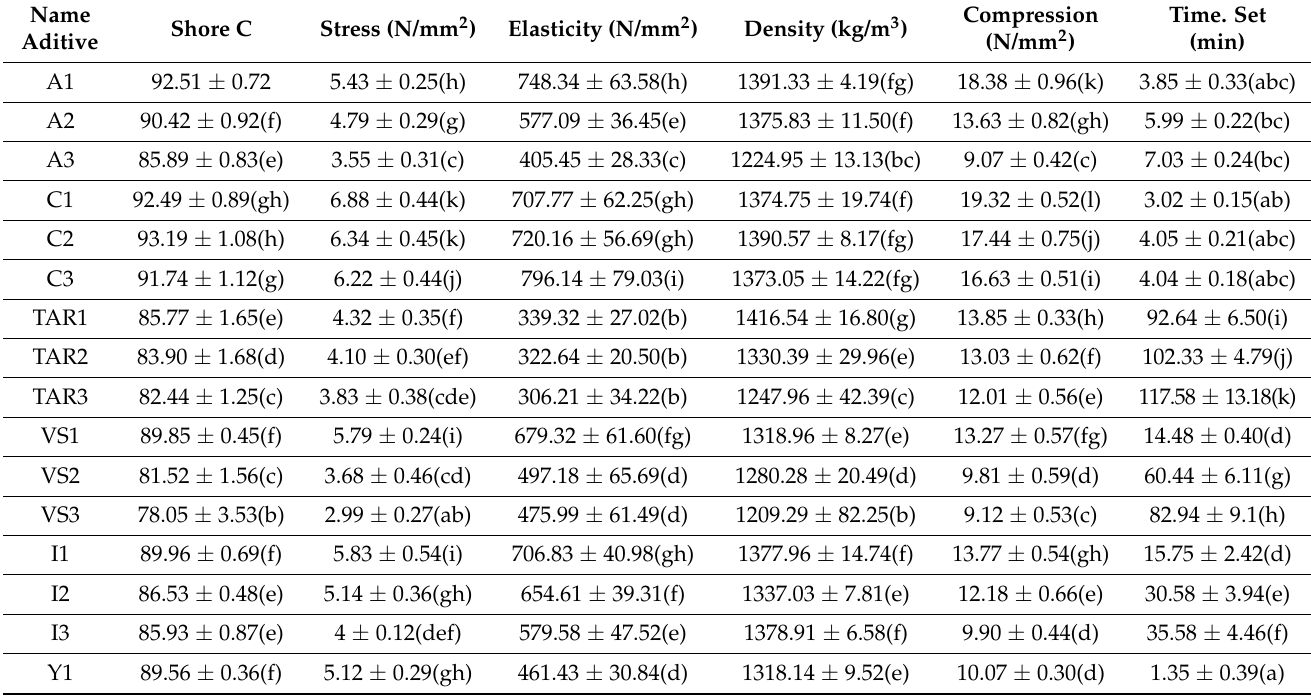
Table 4. Average results and standard deviation for reference Y1 without